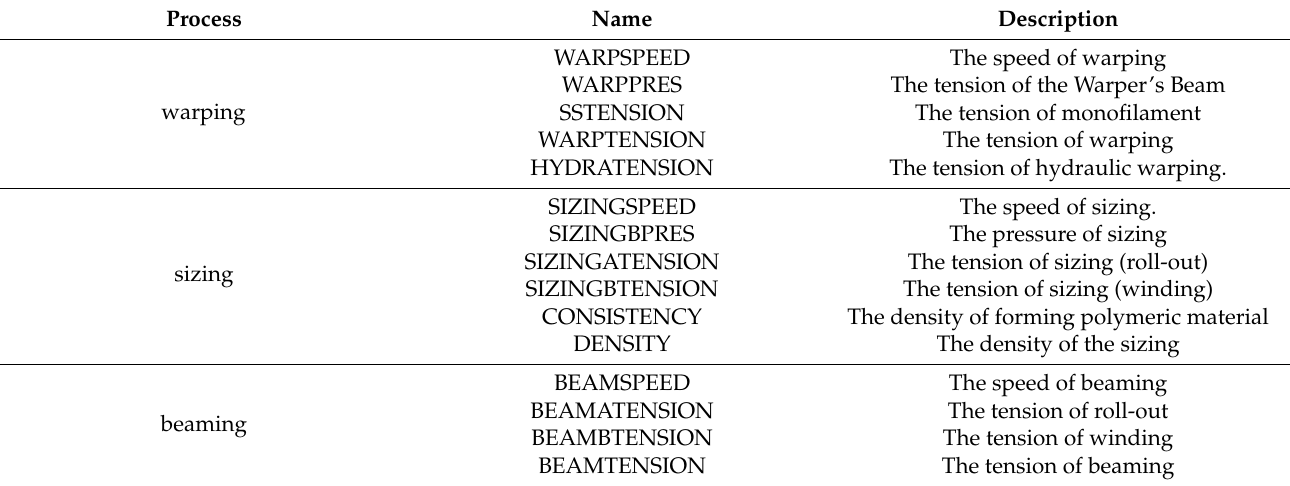
Table 5. Target equipment setting